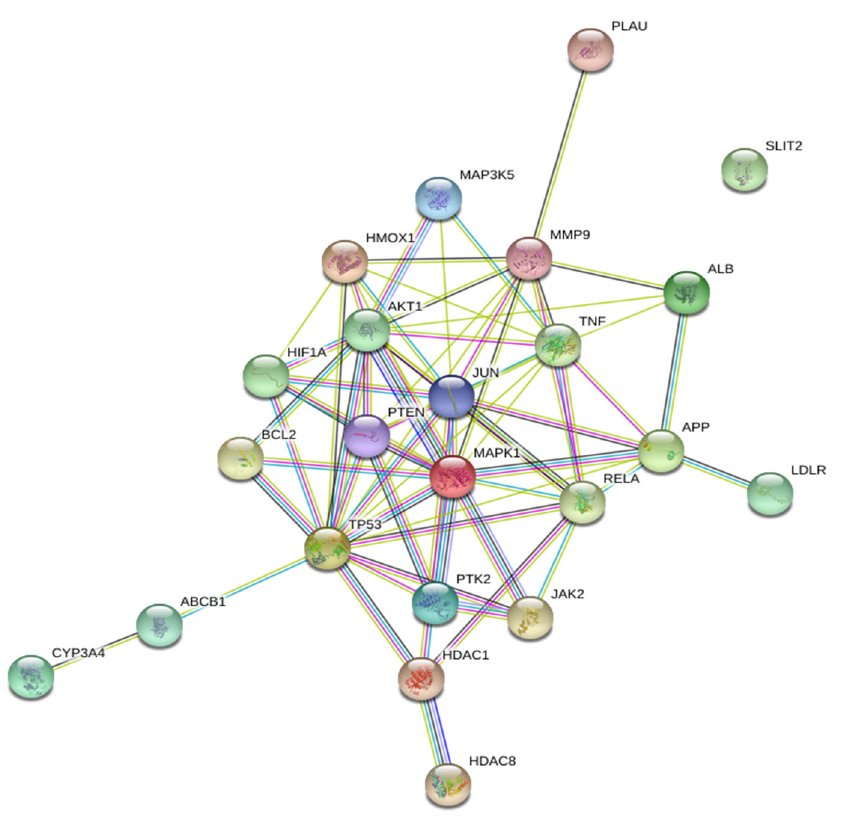
Figure 3. Protein–protein Interaction (PPIs) network constructed using the STRING database. In total, 23 overlapping targets of curcumin and influenza were used as input for the STRING database to construct a PPI network. Two main targets, TP53 (tumor protein 53) and AKT1 (RAC-alpha serine/threonine-protein kinase) were identified in this network.